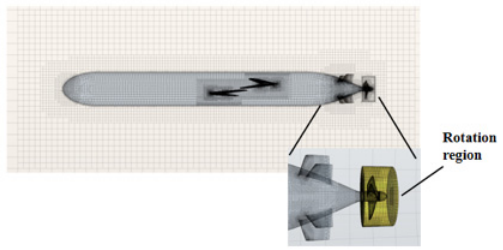
Figure 26. Mesh of the hybrid-driven AUG with the single propeller. The propeller rotation rates were initially set as 720 rpm and 900 rpm. The designed speed of the hybrid-driven AUG was 1.4 m/s. With a given in fl ow velocity, the propeller was set to rotate at di ff erent rotation rates to monitor the resistance of the bare AUG hull and the propeller thrust, as shown in Figure 27.